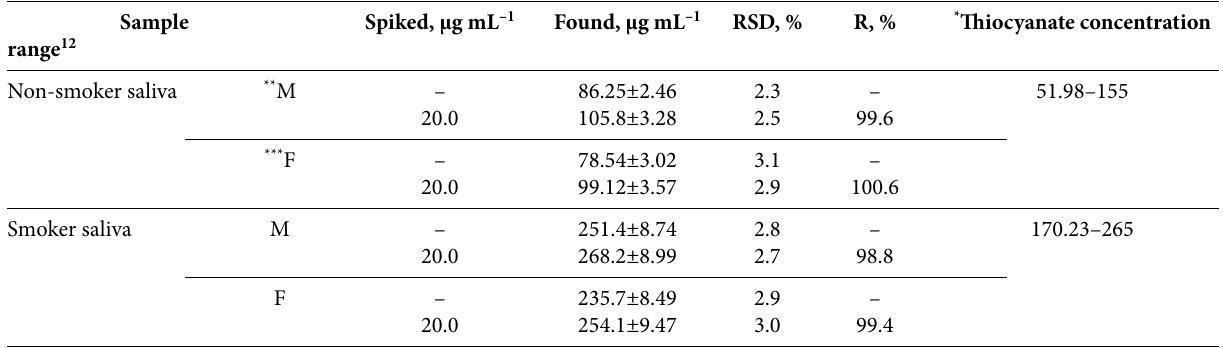
Table 1 .Determination of thiocyanate in human saliva by the proposed method (n = 5, P = 0.95)